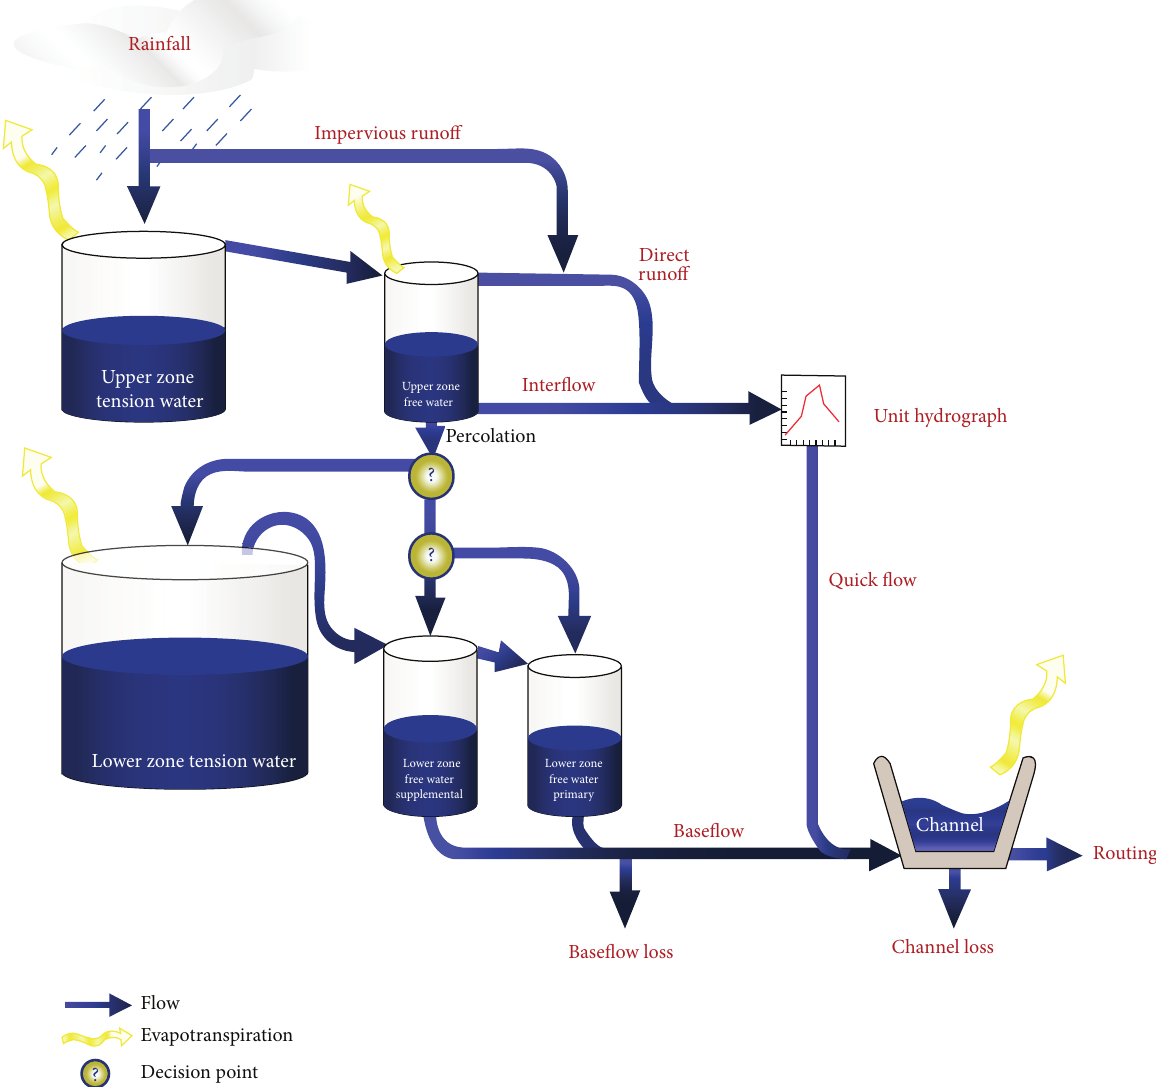
Figure 13: The SAC model structure (Source: RRL